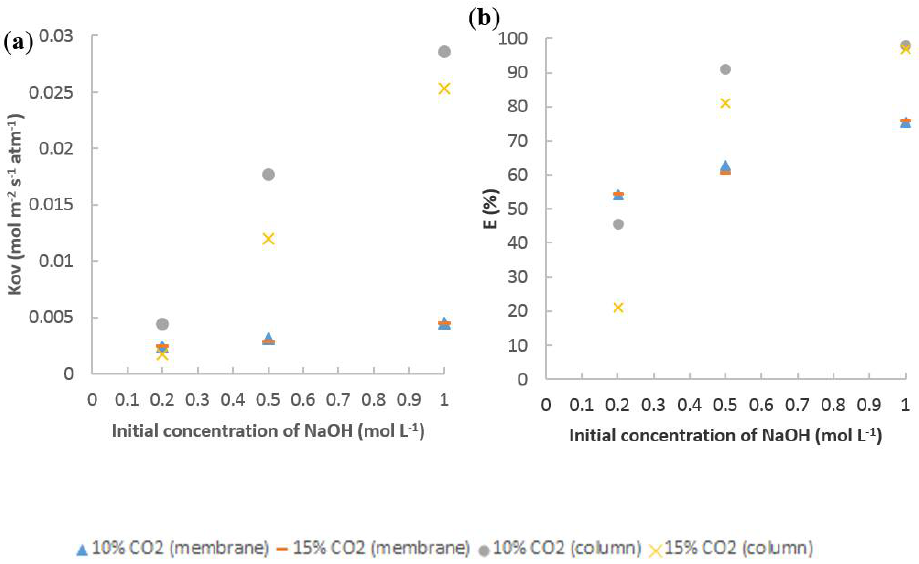
Figure 5. ( a ) Mass transfer coefficient in function of the NaOH initial concentration in the solvent for different CO 2 concentrations in the flue gas in the two set ups; ( b ) CO 2 removal efficiency. The solvent and the flue gas flow rates in the column and the membrane contactor are 5 and 33 L min −1 and 1 and 23.5 L min −1 , respectively.